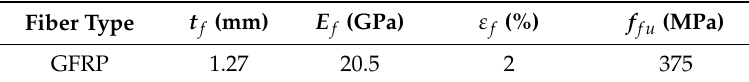
Table 9. FRP properties for set 2